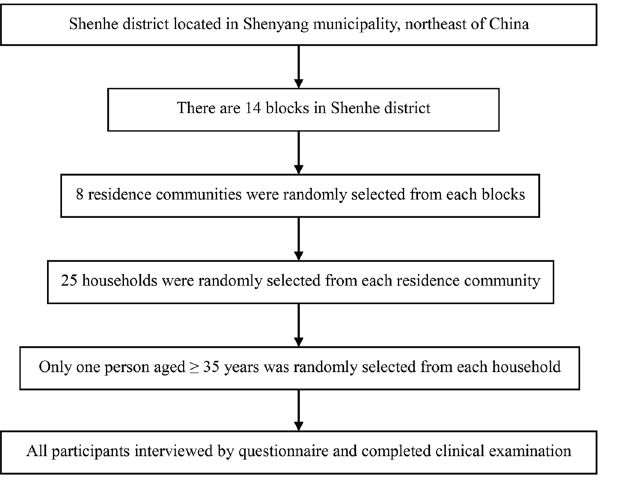
Figure 1. The sampling procedure of the